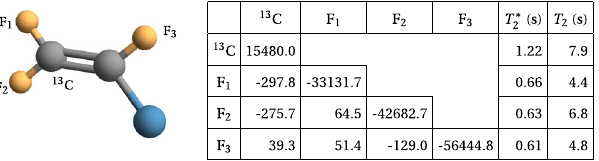
FIG. 5. Characteristics of iodotrifluroethylene. Molecular struc- ture together with a table of the chemical shifts (on the diagonal) and J -coupling strengths (lower off diagonal), all in Hz. The chemical shifts are given with respect to base frequency for 13 C or 19 F transmitters on the 400-MHz spectrometer that we